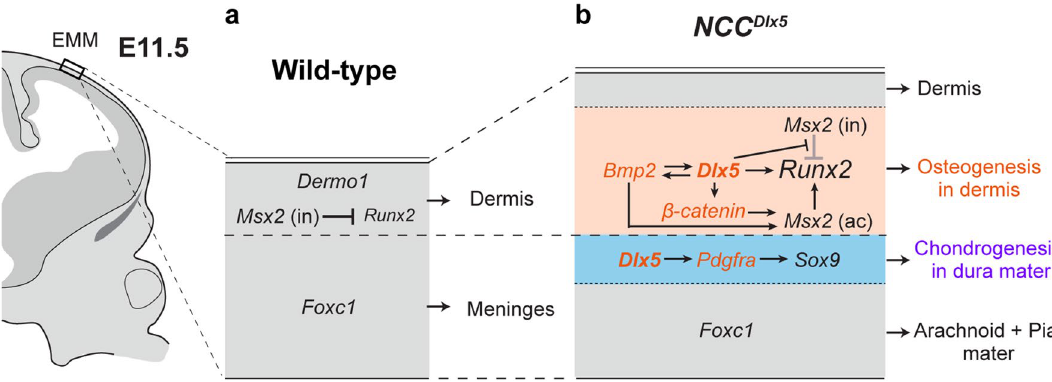
Figure 8. Proposed regulatory molecular cascades in EMM development at E11.5. In the control ( a ), the EMM develops into dermal and meningeal layers. The dermis is marked by a dermal marker- Dermo1 . Runx2 and Msx2 are expressed in the dermis and Msx2 [ Msx2 (in)] inhibits osteogenic induction of Runx2 , consequently bone is not formed in the dermis. Foxc1 is expressed underneath the dermal layer to induce meningeal cell differentiation. In the NCC Dlx5 ( b ), Dlx5 upregulates Pdgfra in the dura mater to generate the ectopic cartilage at the interfrontal and NCC-MES boundary area. In the dermis layer, Dlx5 inhibits the anti-osteogenic function of Msx2 [ Msx2 (in)] but support the pro-osteogenic function of Msx2 [ Msx2 (ac)] by upregulating Bmp2 and β-catenin, resulting in Runx2 upregulation. Consequently, osteogenesis is activated in the apical head mesenchyme to form the heterotopic bone. ac, activator; in,